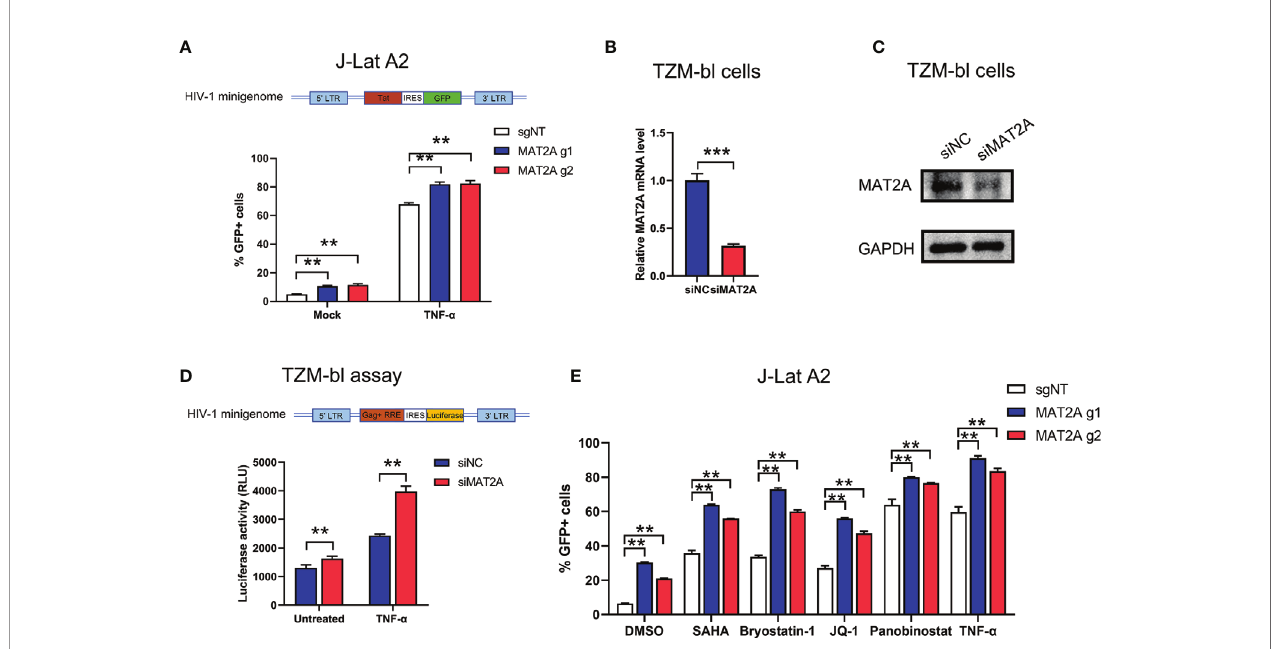
FIGURE 5 | MAT2A regulates latent HIV-1 reactivation by modulating promoter activity. (A) Flow cytometry analysis of GFP-positive cells in MAT2A knockout J-Lat A2 cells with or without TNF- a stimulation. sgNT knockout cells served as control. (B, C) The knockdown ef fi ciency by MAT2A siRNA was con fi rmed by RT-qPCR and Western blot. (D) TZM-bl cell line was transfected with siNC or siMAT2A for 48 h, then stimulated with or without TNF- a for 24 h Cells were harvested and the activity of luciferase was measured. (E) MAT2A knockout J-Lat A2 cells were treated with DMSO, SAHA, Bryostatin-1, JQ1, Panobinostat and TNF- a for 24 h GFP- positive cells were measured by fl ow cytometry. Data were presented as mean ± SD from three independent experiments (Student ’ s t-test, **p < 0.01, ***p <